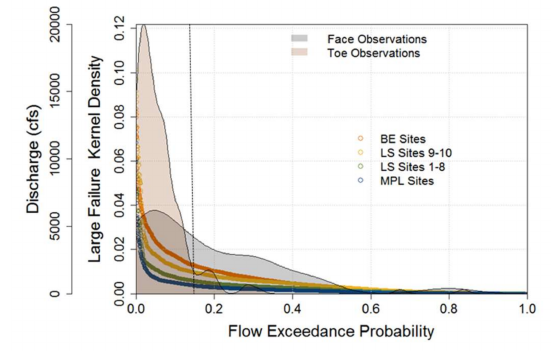
Figure 5. Distributions of large toe and face failures plotted as kernel density functions of flow exceedance probabilities. Dashed vertical line indicates 15% exceedance probability flows. Behind the kernel density functions, four flow duration curves are plotted, corresponding to gages for each of the bluff sites (described in Section 2.3.4); BE: Blue Earth River sites, LS: Le Sueur River sties, MPL: Maple River